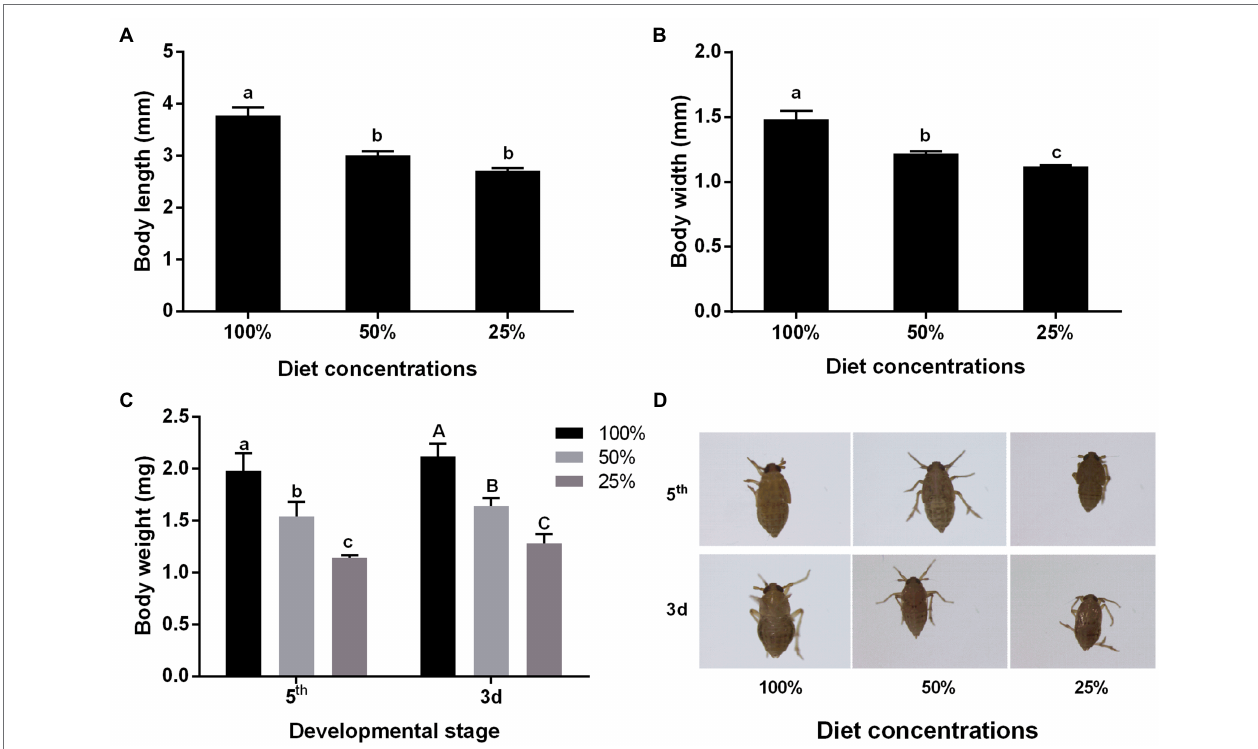
FIGURE 1 | Effect of different nutrient concentrations on the body shape of the brown planthopper (BPH). (A) Body length; (B) Body width; (C) Weight (fifth: fifth- instar nymph; 3d: Adult of 3 day old); and (D) Phenotype (fifth: fifth-instar nymph; 3d: Adult of 3 day old). Data are presented as mean ± SE ( n = 3); different letters above the same index data indicate significant differences ( p < 0.05, Duncan’s multiple range